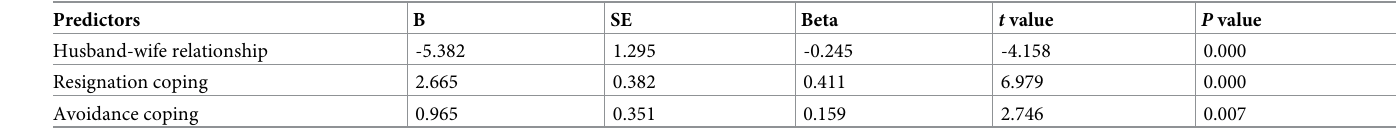
Table 4. Multivariate linear stepwise regression analysis of general distress among participants (n =